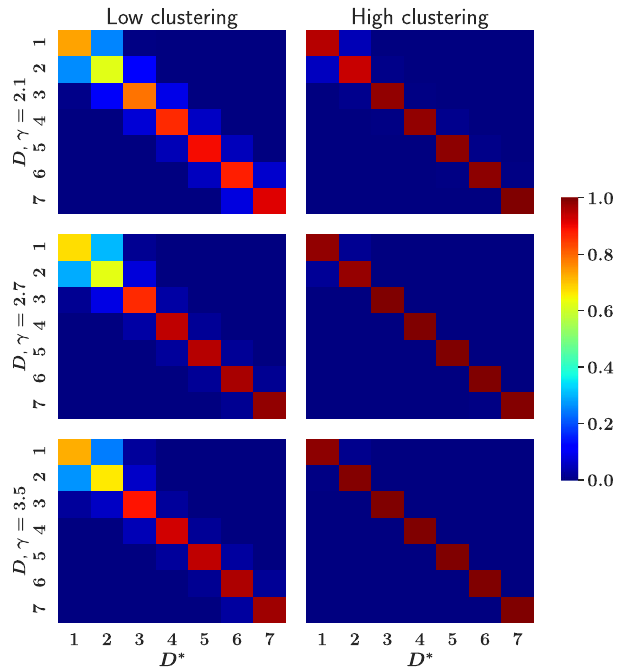
Fig.3|Confusionmatrices. Theleftcolumnshowsresultsfor β =1.5 D anddifferent valuesof γ .Thischoiceof β correspondstothesmall-worldphaseevenif γ >3.The rightcolumnshowsthesamefor β =2.5 D .Inthiscase,networkswith γ >3arelarge- worlds. The color in each D − D * box indicates the probability that the predicted dimension is D * when the dimension used to generate the synthetic network is D . Each panel is evaluated with approximately 5×10 3 networks, more details in sub- section “ Calculation of confusion matrices ” in